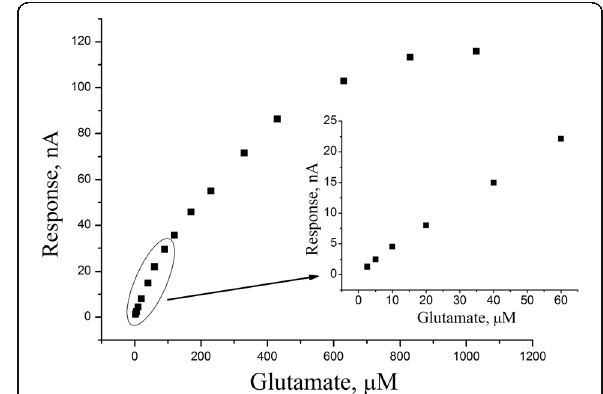
Fig. 6 Dependence of responses of biosensor based on GlOx, adsorbed on silicalite, on enzyme concentration at membrane deposition. Measurements in 20 mM HEPES buffer, pH 7.4, at a constant potential of +0.6 V vs Ag/AgCl reference electrode.